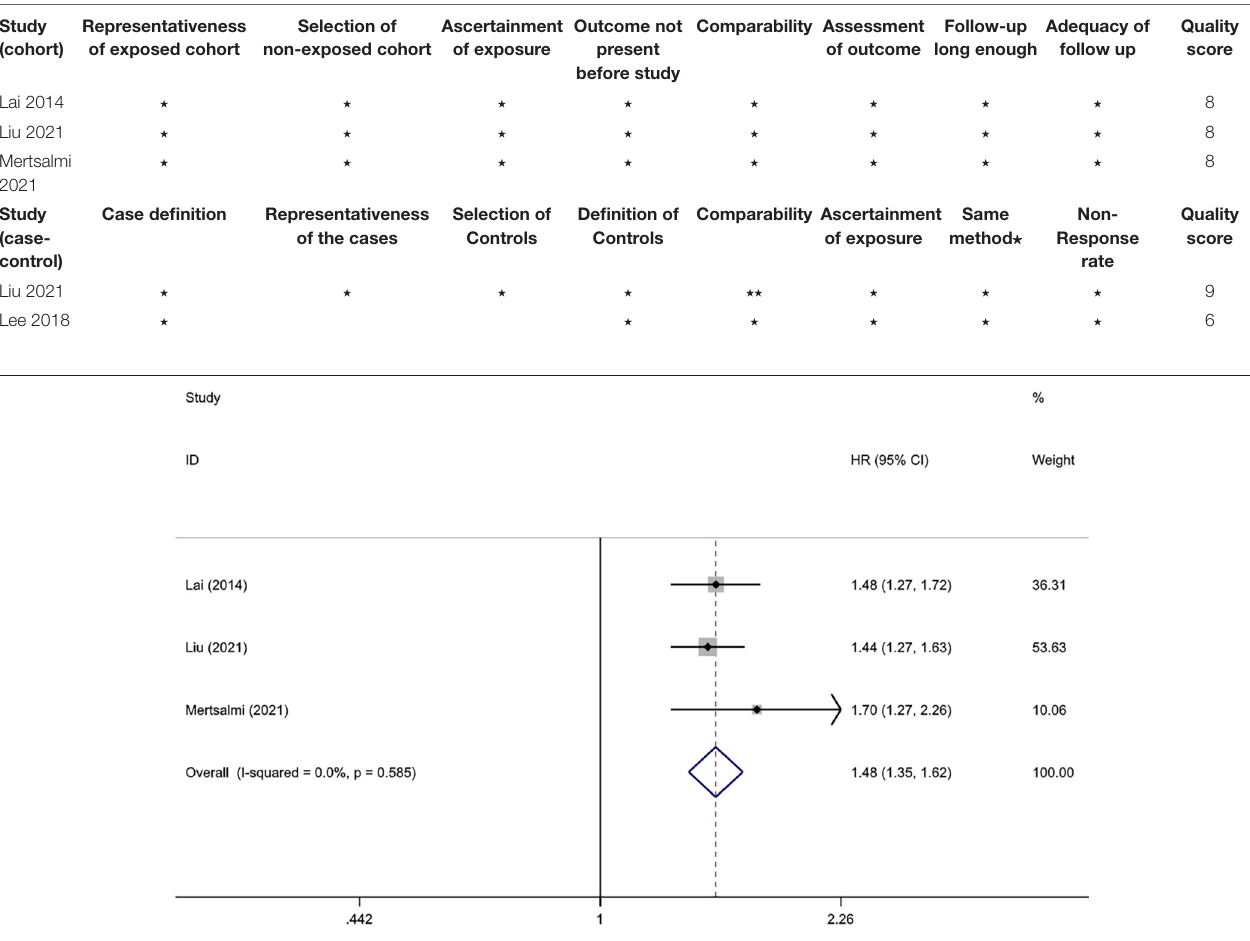
TABLE 2 | The quality assessment of included studies.